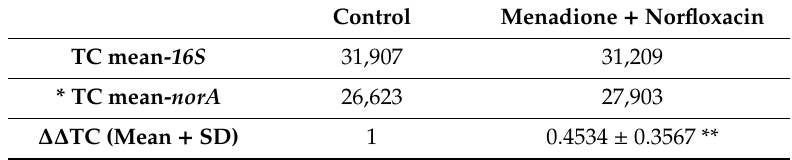
Figure 4. Relative norA gene expression in S. aureus 1199B in the presence of menadione associated with norfloxacin in comparison to the growth control: ( A ) comparison between growth control and association; ( B ) comparison between growth control and norfloxacin alone. Table 2. Relative expression of the norA gene in S. aureus strain in presence of tannic acid. ** p < 0.01.